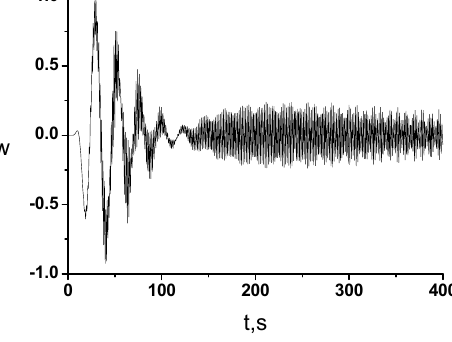
Figure 8. The scaling factor is equal to 4.